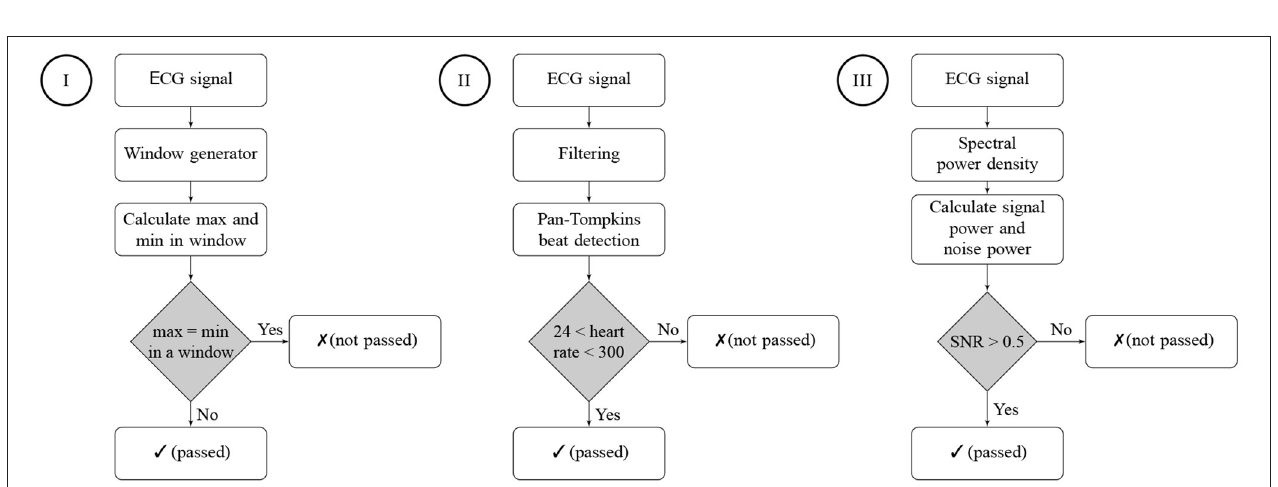
FIGURE 2 | Six examples of ECG signals that were classified and annotated into acceptable and unacceptable with respect to their quality. The filtered signals were visually classified, with a focus on the heartbeats. If all heartbeats were visible, the quality was considered acceptable.